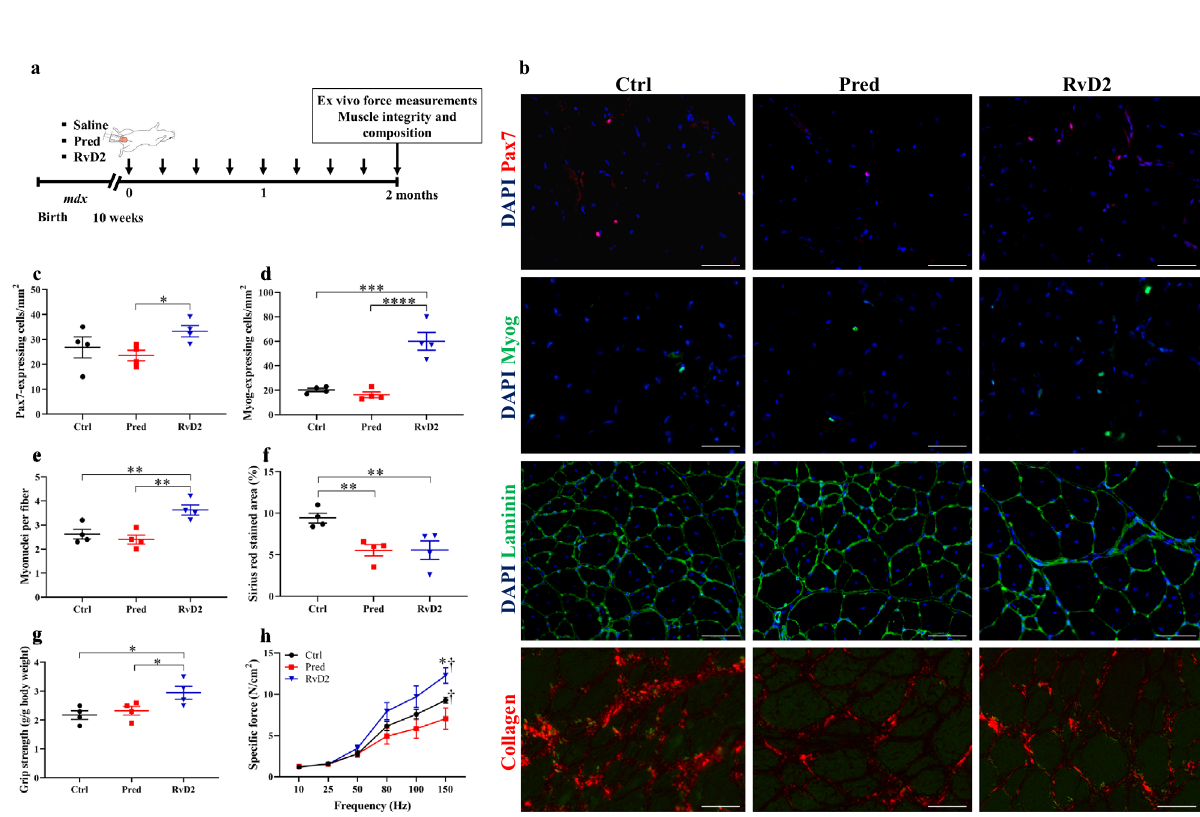
Fig. 7 The superior therapeutic effect of RvD2 is maintained at long term in mdx mice. a Timeline of weekly ip injection of either RvD2 (5 μ g/kg), prednisone (pred, 2 mg/kg), or vehicle (ctrl) into mdx mice for 2 months. b Representative images of Pax7 (red), Myog (green), laminin (green), DAPI (blue), or collagen (red) immunohistological staining in muscle section of tibialis anterior (TA) muscle (for Pax7, Myog, laminin) or diaphragm muscle (for collagen staining) of treated mdx mice. Scale bars = 50 μ m. c , d Quanti fi cation of total number of Pax7 + cells ( c ) (Ctrl vs. Pred, p = 0.4663; Ctrl vs. RvD2, p = 0.1625; Pred vs. RvD2, p = 0.0484) and Myog + differentiated myoblasts ( d ) (Ctrl vs. Pred, p = 0.5438; Ctrl vs. RvD2, p = 0.0001; Pred vs. RvD2, p < 0.0001) in TA muscles of mdx mice treated for 2 months. e Number of myonuclei per fi ber in TA muscles of mdx mice treated for 2 months (Ctrl vs. Pred, p = 0.4460; Ctrl vs. RvD2, p = 0.0063; Pred vs. RvD2, p = 0.0019). f Quanti fi cation of Sirius red positive area (collagen) in diaphragm muscles of mdx mice treated for 2 months (Ctrl vs. Pred, p = 0.0089; Ctrl vs. RvD2, p = 0.0092; Pred vs. RvD2, p = 0.9834). g Grip strength measured in treated mdx mice after 7 weeks of treatment (Ctrl vs. Pred, p = 0.5667; Ctrl vs. RvD2, p = 0.0133; Pred vs. RvD2, p = 0.0351). h Speci fi c muscle force (N/cm 2 ) of EDL muscles of mdx mice treated for 2 months (150 Hz: Ctrl vs. Pred, p = 0.0298; Ctrl vs. RvD2, p = 0.0048; Pred vs. RvD2, p < 0.0001). c – h RvD2 = blue triangles, pred = red squares or Ctrl = black circles. Data are presented as mean ± SEM, n = 4 (except n = 3 for h ) mice per group. Experiments were performed in technical duplicates using one-way ( c – g ) or two-way ( h ) ANOVA uncorrected Fisher ’ s LSD test. All data were analyzed with a 95% con fi dence interval. * p < 0.05; ** p < 0.01; *** p < 0.001; **** p < 0.0001 for c – g . * p < 0.05 compared with the vehicle; † p < 0.05 compared with prednisone for h